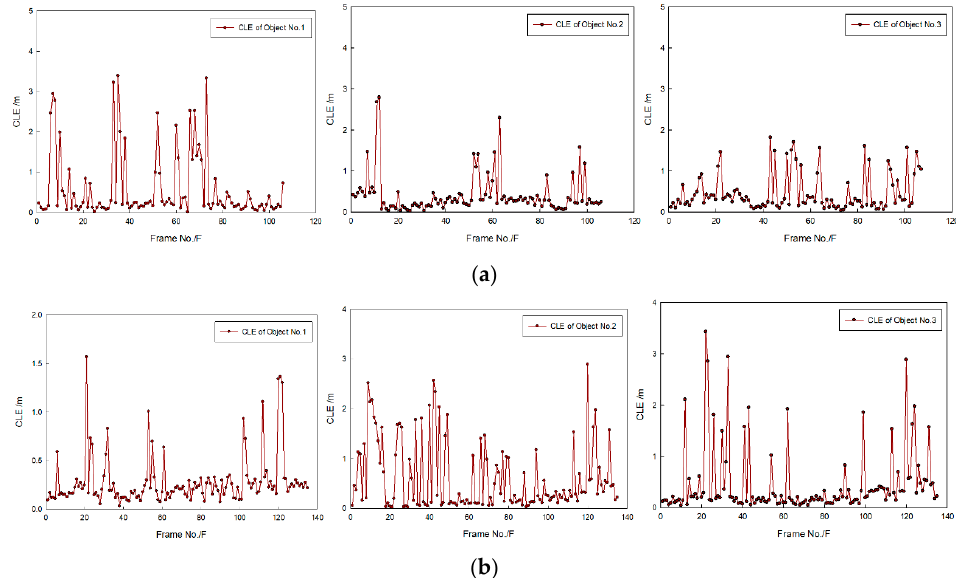
Figure 24. CLE gained by proposed method: results in ( a ) first and ( b ) second sequence of FLS images.